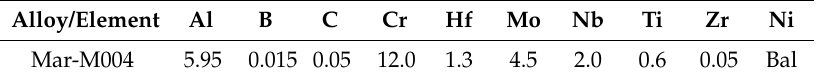
Table 1. The chemical compositions of Mar-M004 in wt.